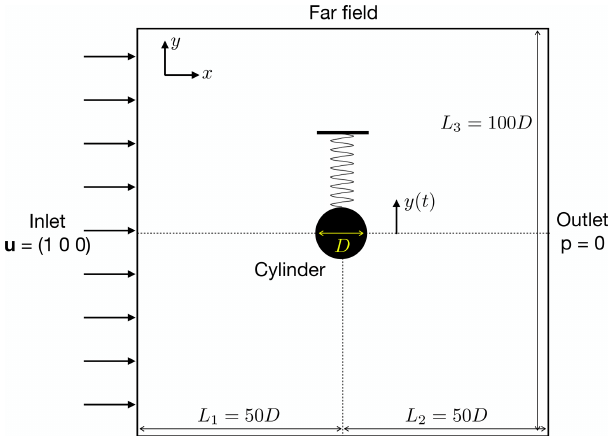
Figure 2. Sketch of the computational